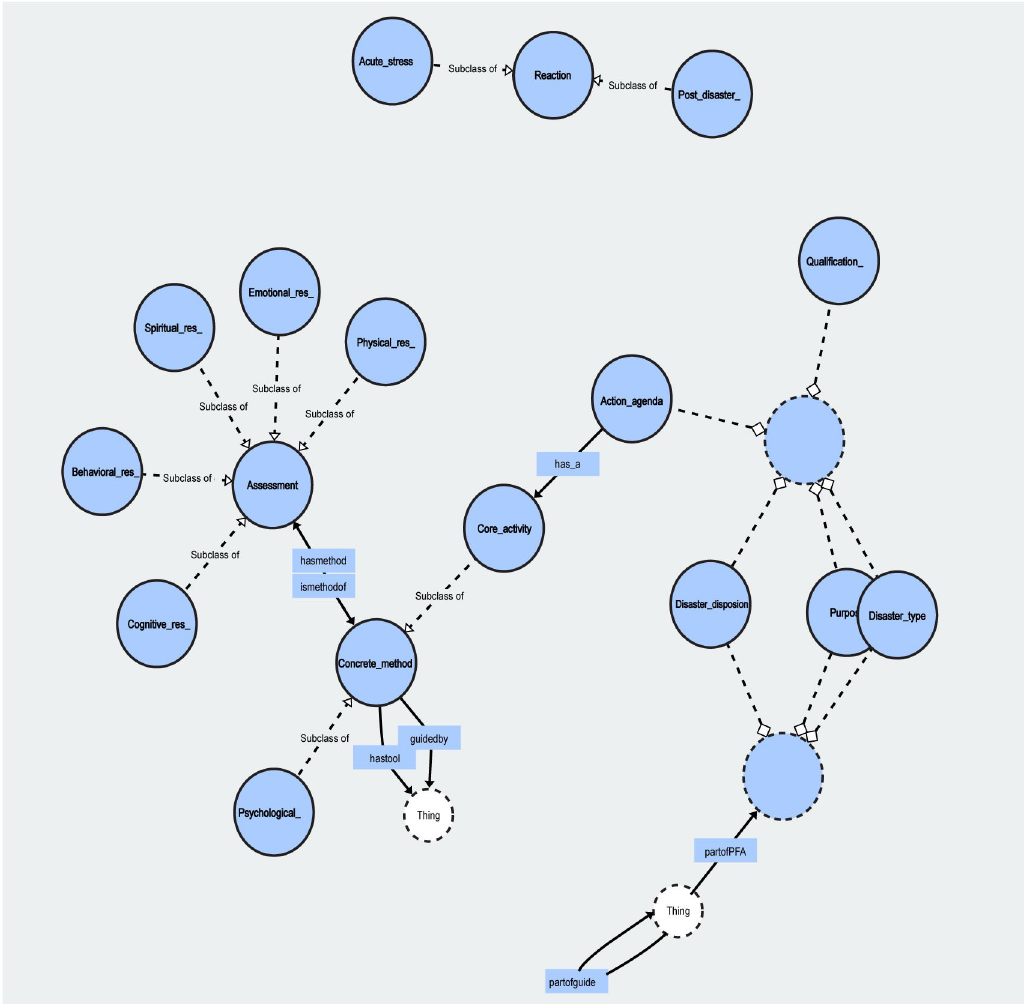
Fig 3. Psychological first aid ontology implementation.